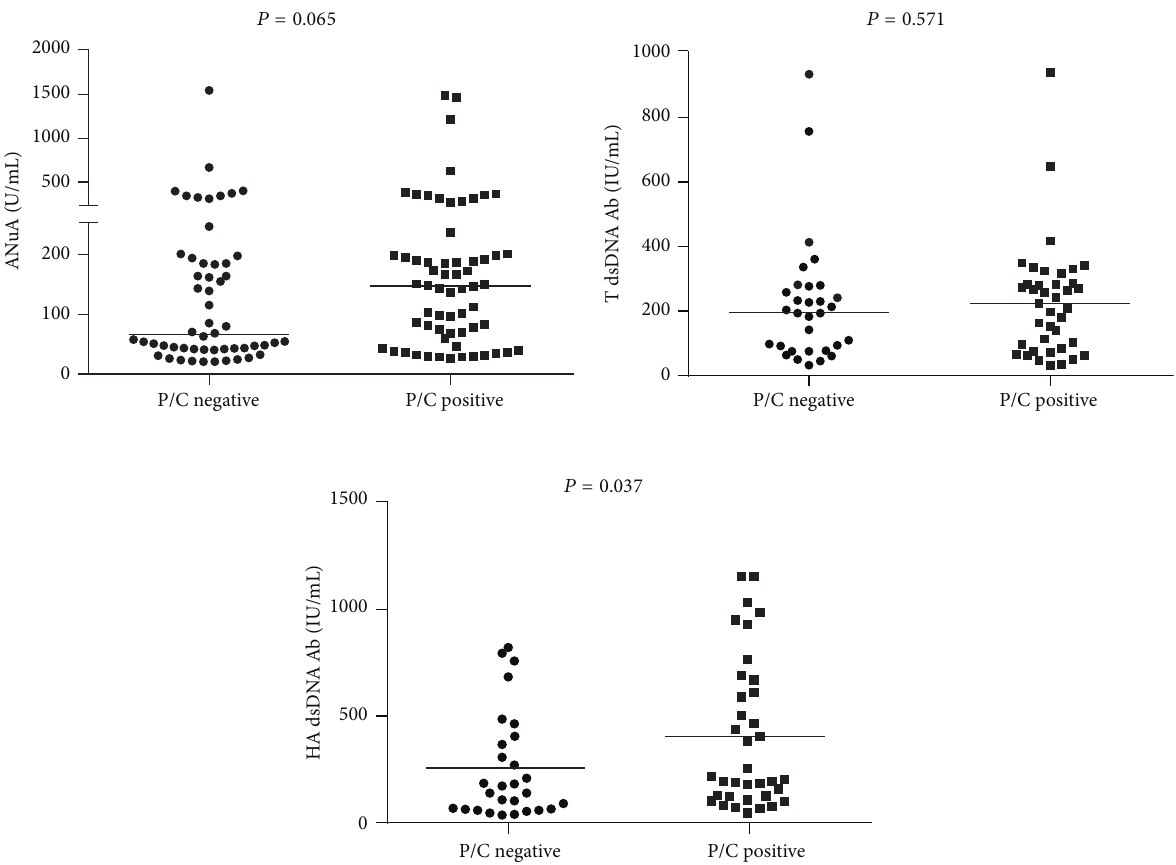
Figure 2: Levels of total dsDNA antibodies, HA dsDNA antibodies, and ANuA in SLE Brazilian women without and with proteinuria (P/C ratio ≤ 0.23 and > 0.23, resp.). The medians are represented by horizontal lines and were compared with the 𝑈 test of